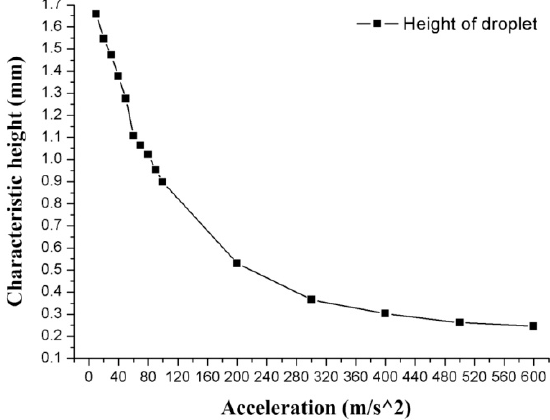
Figure 7. The relationship between the C-height and the acceleration.